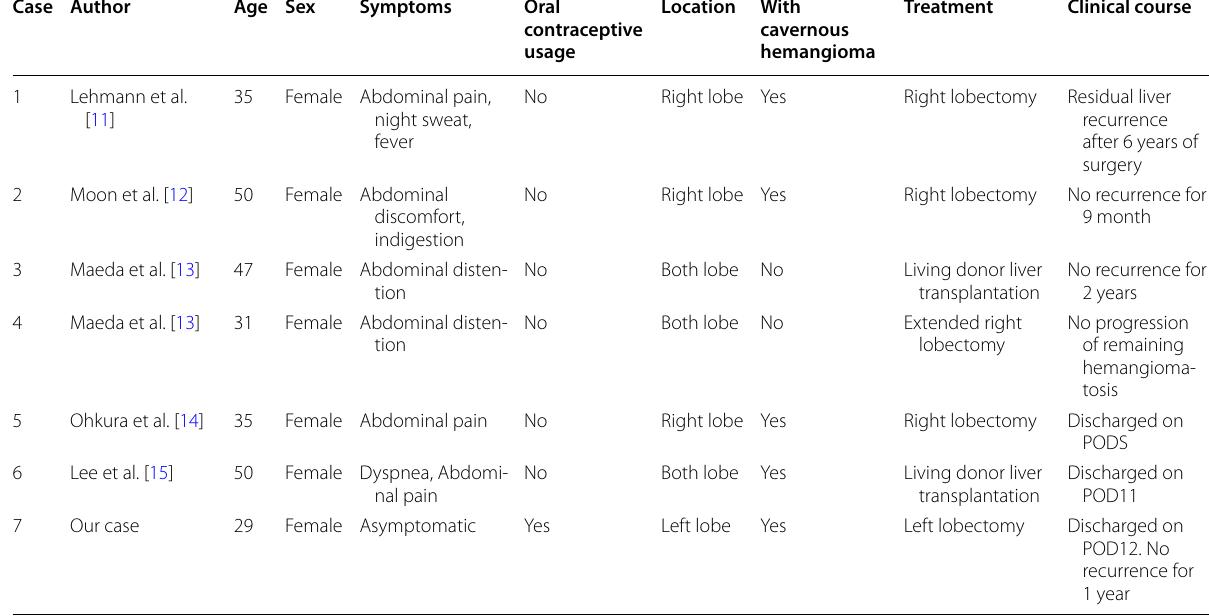
Table 1 Summary of reported case of surgery treatment for